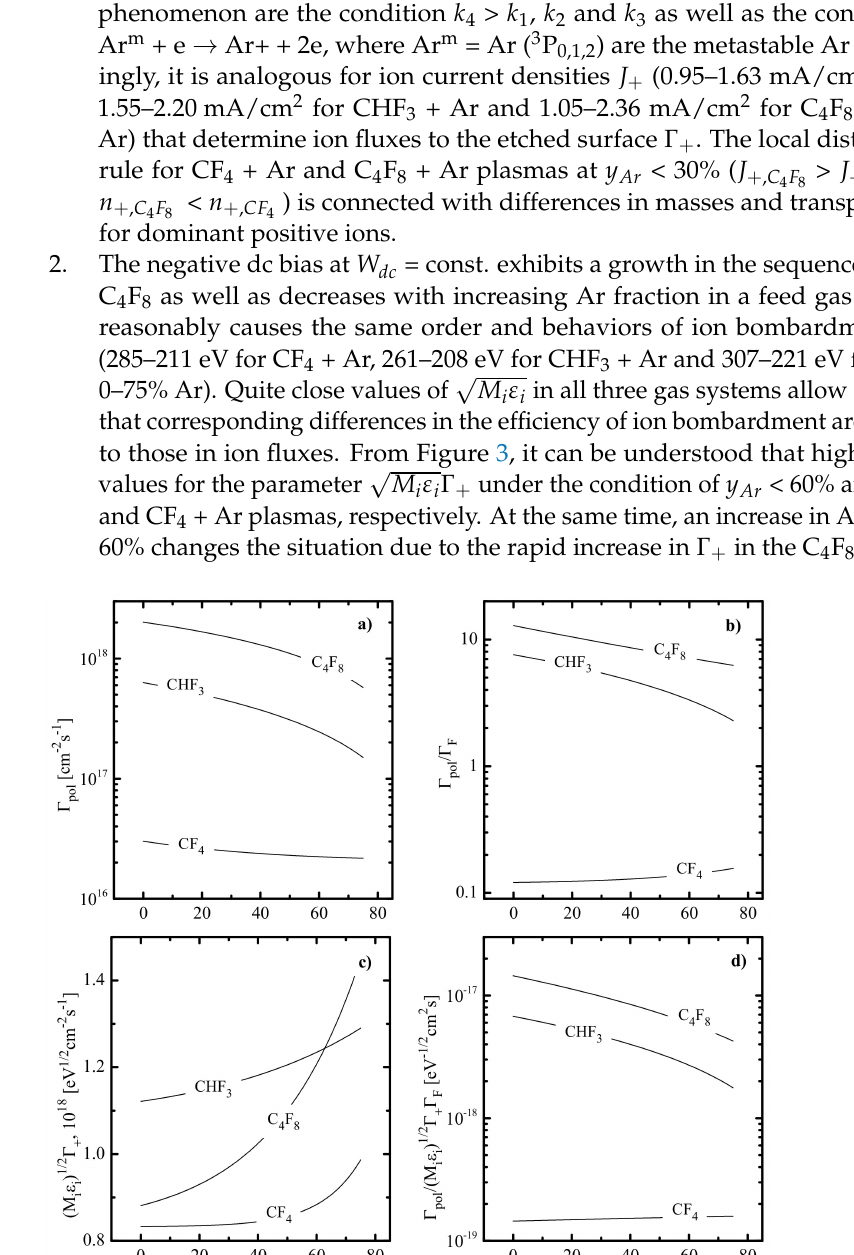
√ M i ε i Γ + Γ F characterizing